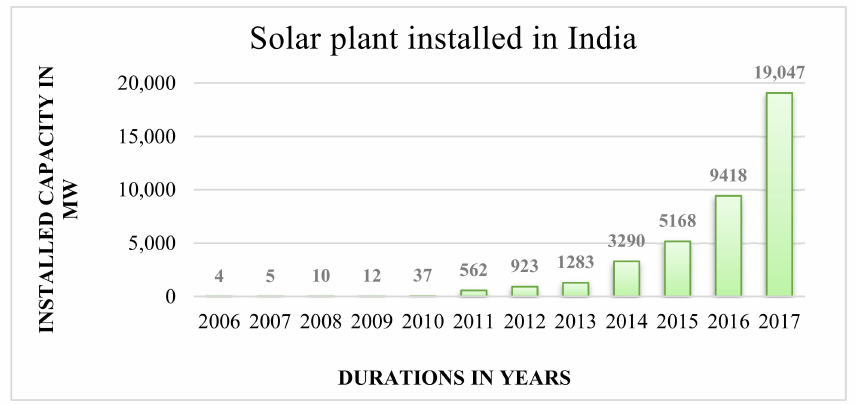
Figure 1. Total installed capacity of solar power sources in India: